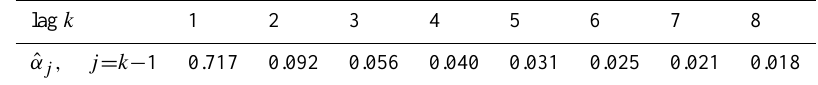
Table 2. Cosenza raingauge: estimated values of the α j coefficients.